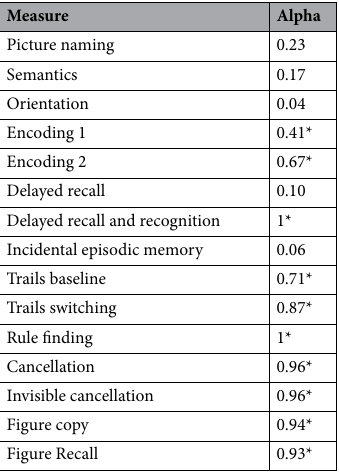
Table 6. Internal split-half consistency (bootstrapped Cronbach’s alpha) per task in the OCS-Plus from 320 neurologically healthy adults. Oxford Cognitive Screen-Plus (OCS-Plus). We used 5000 iterations